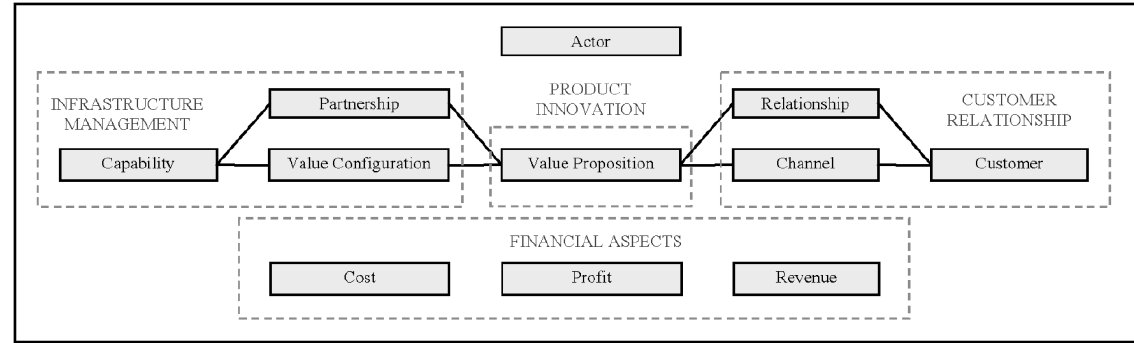
Figure 1: The business model